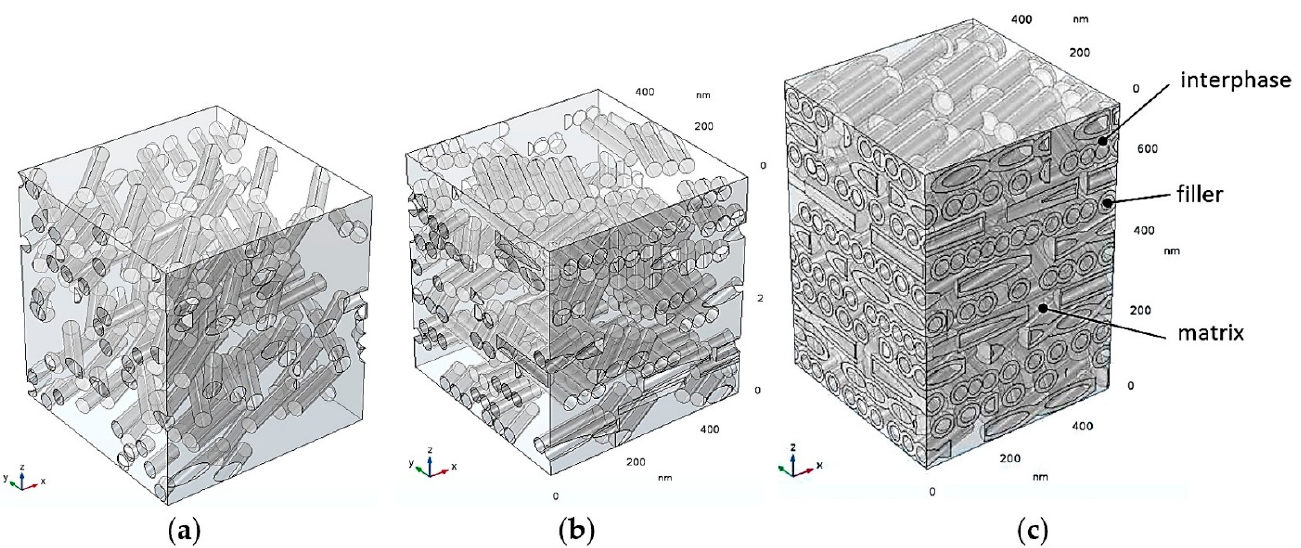
Figure 1. Examples of generated RVEs for the different types of model systems investigated: ( a ) 2-phase model with isolated fillers; ( b ) 2-phase model with agglomerated fillers; ( c ) 3-phase model with filler–matrix interphase areas.